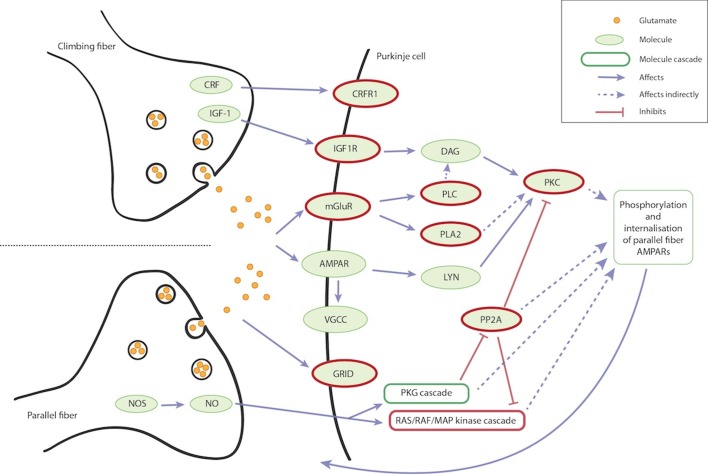
Synaptic long-term depression pathway.The LTD pathway was found to be overrepresented among genes suggestively associated with composing. This diagram shows the main molecules and their relationships that are involved in the LTD process. The climbing fibre originates from inferior olive and parallel fibres from the cerebellar cortex. There are various parallel fibres in contact with each Purkinje cell. Stimuli from climbing and parallel fibre impact Purkinje cell partially through the same receptors (mGluR and AMPAR). Parallel fibres function also through NO and GRID; the climbing fibre through CRFR1 and IGF1R. The climbing and parallel fibres are here shown side by side, but they may reside on different parts of the Purkinje cell. The pathway influences phosphorylation and internalization of AMPAR in parallel fibre, which in turn affects the synaptic function for future stimuli. The molecules and cascades related to genes that were suggestively associated with composing are lined with red (see Table 4).